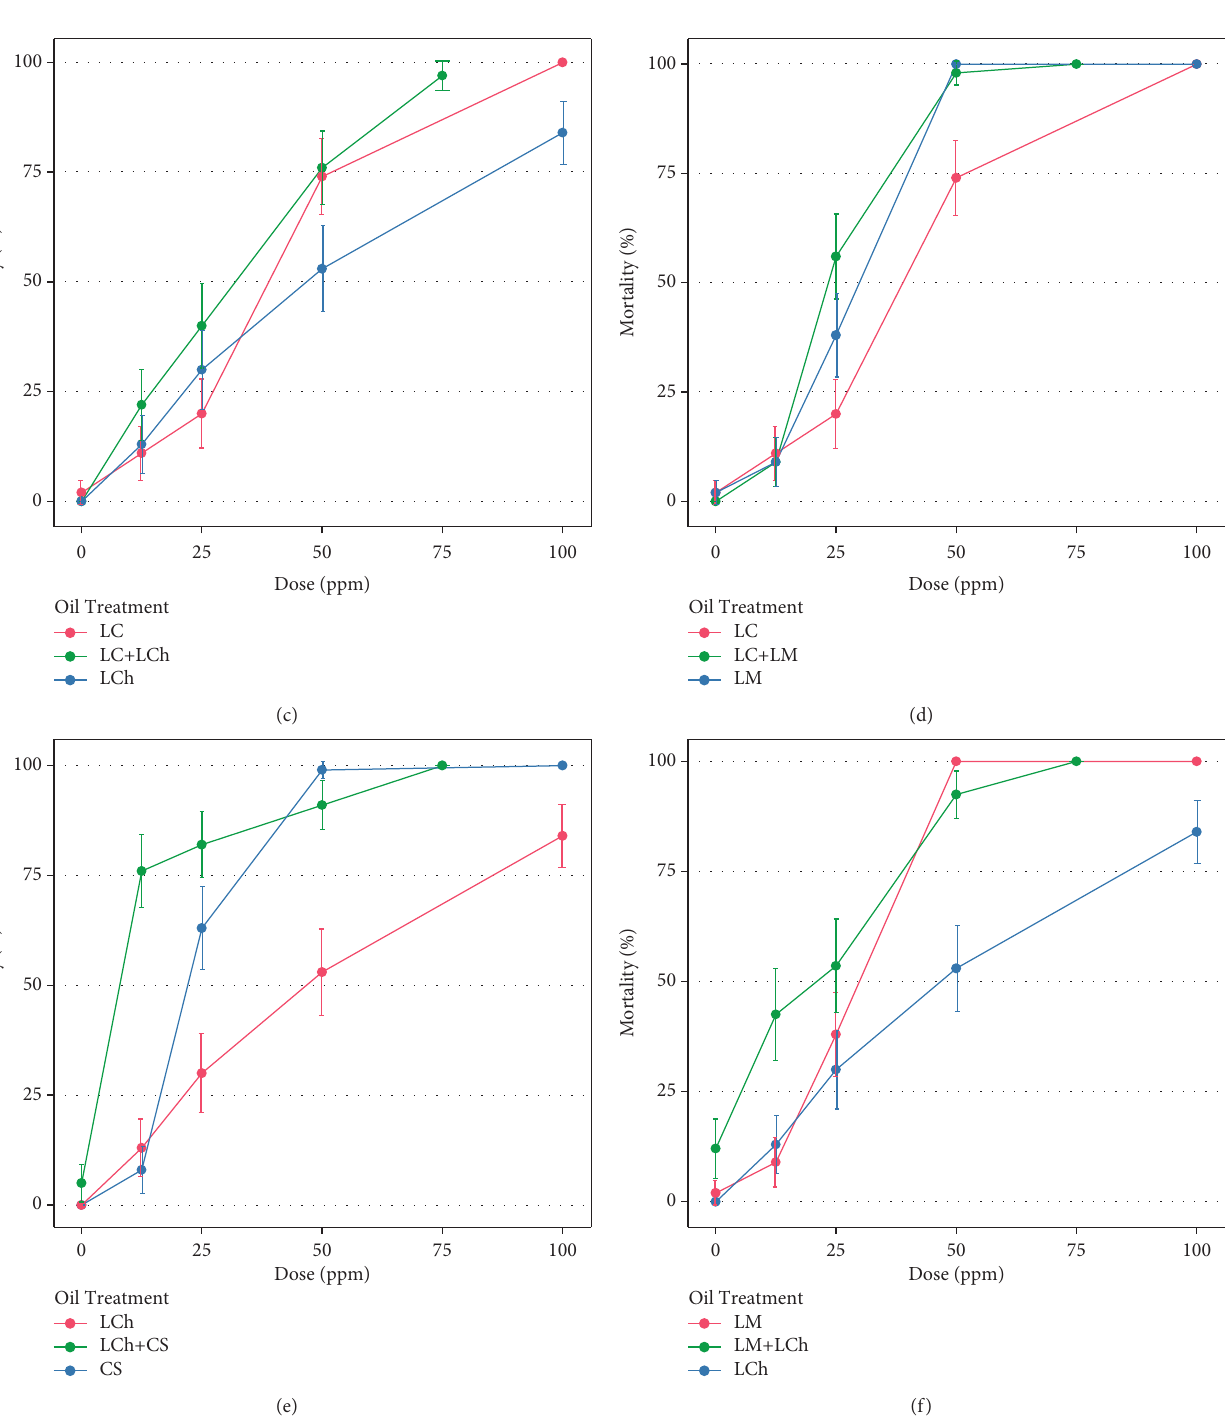
Figure 2: Larval mortality rate on the 3 rd –4 th instar larvae of Culex quinquefasciatus after exposure to various concentrations of essential oils and their mixtures. LM : Lippia multiflora ; LCh : Lippia chevalieri ; LCa : Lantana camara ; CS : Cymbopogon schoenanthus